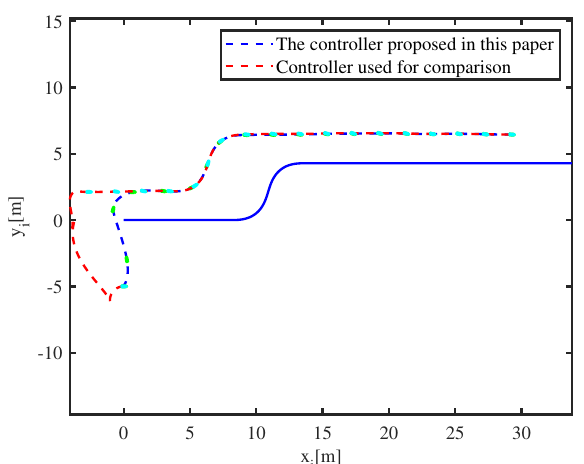
Figure 13. Formation process of the 1st USV under different controllers, (blue solid line represents the position of USV 0).